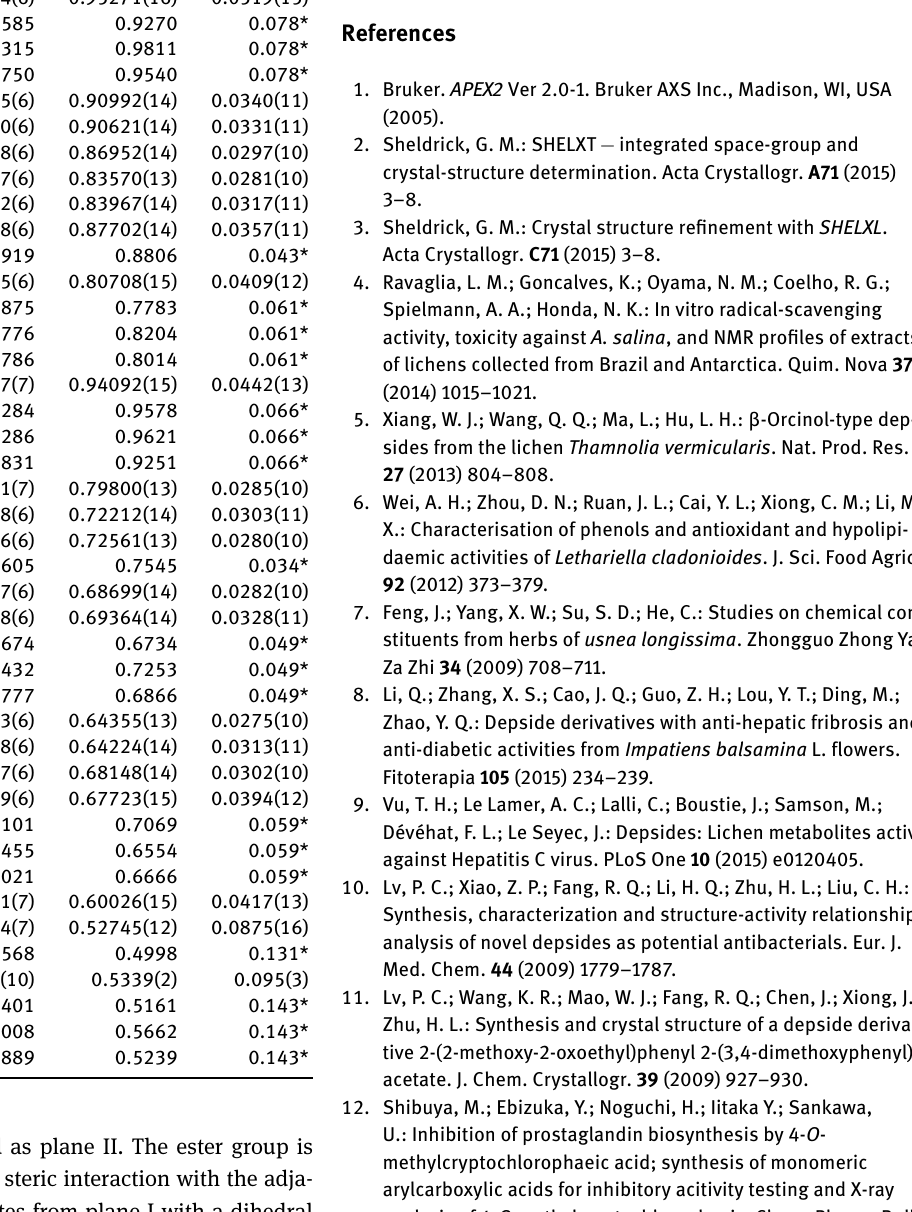
and C17) by 5.3(4)°, defined as plane II. The ester group is defined as plane III. For the steric interaction with the adja- cent groups, plane III deviates from plane I with a dihedral angle of 13.9(3)°. In addition to two intramolecular